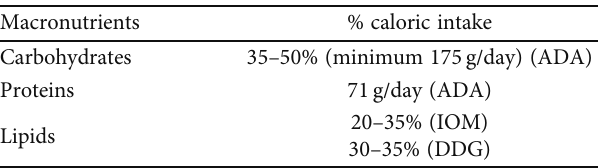
Table 5: Recommended carbohydrate, protein, and lipid intake in